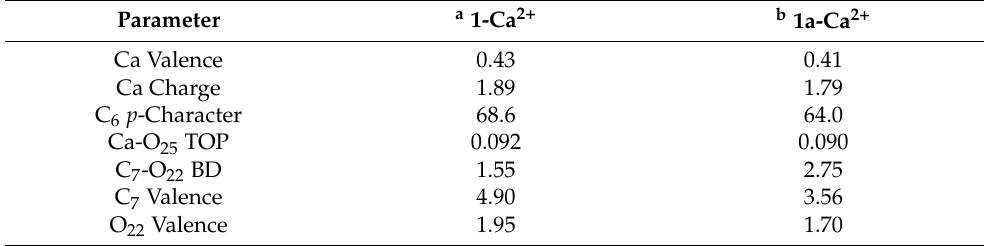
Table 1. Comparison of molecular properties in the interacting complexes of 1 and 1a with Ca 2+ .